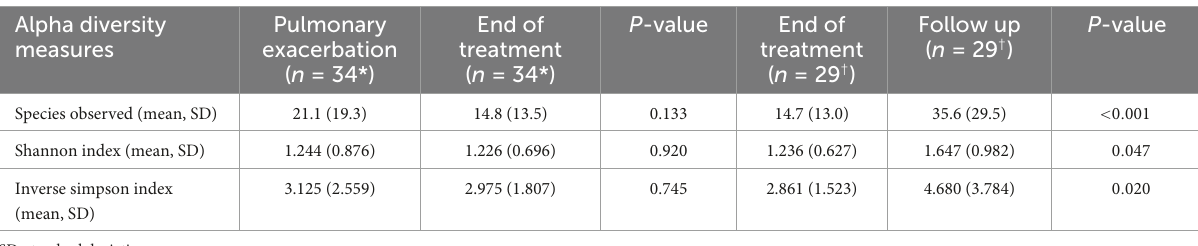
TABLE 2 Alpha diversity measures between time